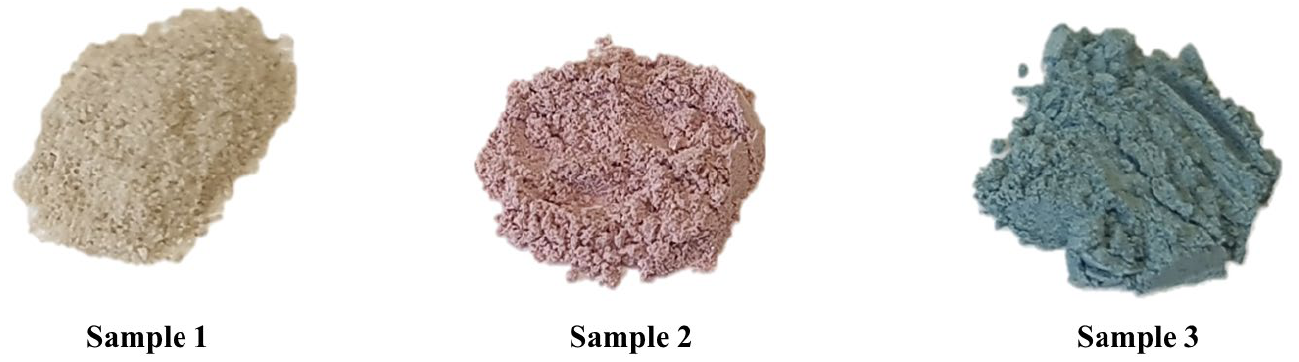
Figure 1. From the left: colourless, pink, and blue powders.